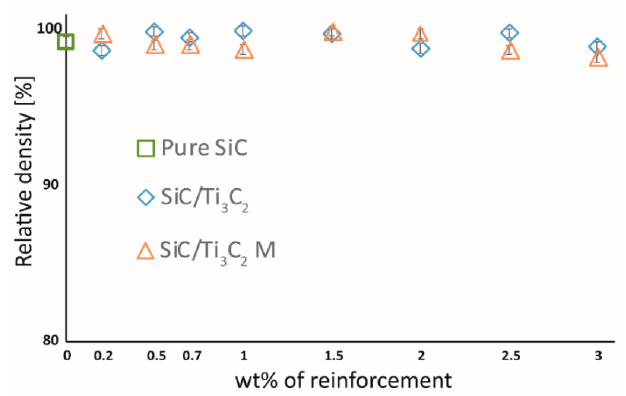
Figure 3. The relative density of obtained composites.